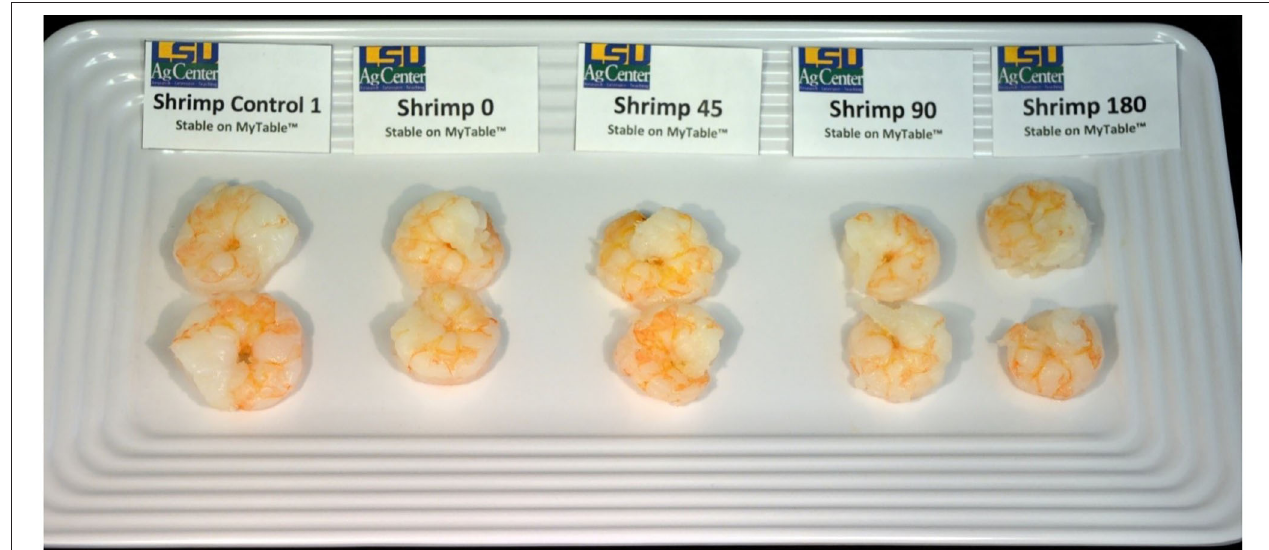
FIGURE 8 | Unprocessed, blanched Louisiana Gulf Coast (LGC) brown shrimp (control 1) compared with retort thermally processed LGC brown shrimp at 0, 45, 90, and 180 SPM.